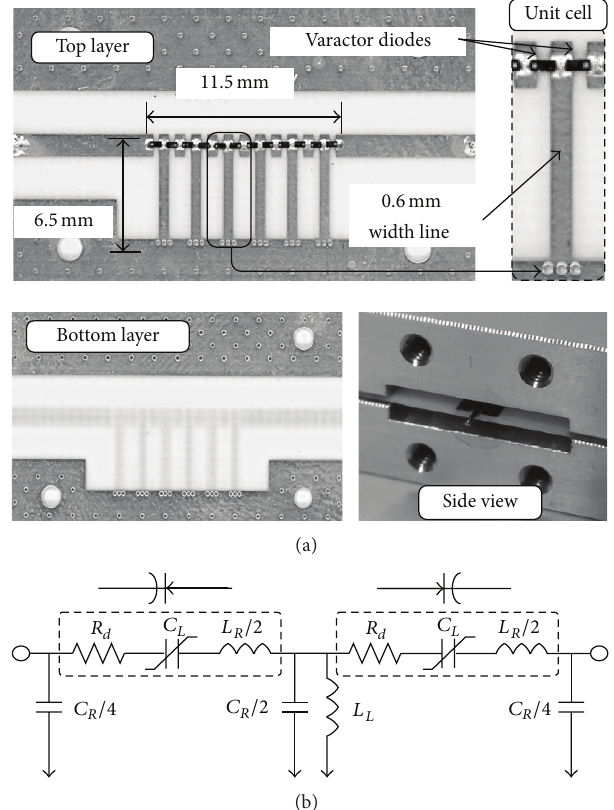
Figure 2: (a) Fabricated third harmonic generator using LH NLTL. (b) Equivalent circuit of a unit